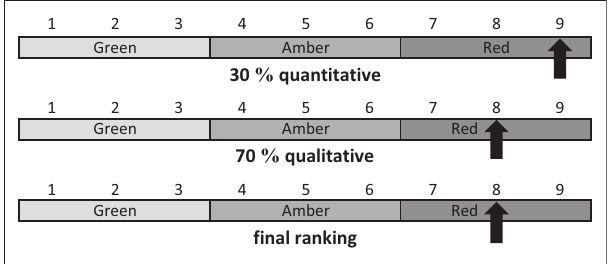
FIGURE 2: Combining a predicted ranking with a qualitative overlay to derive a final